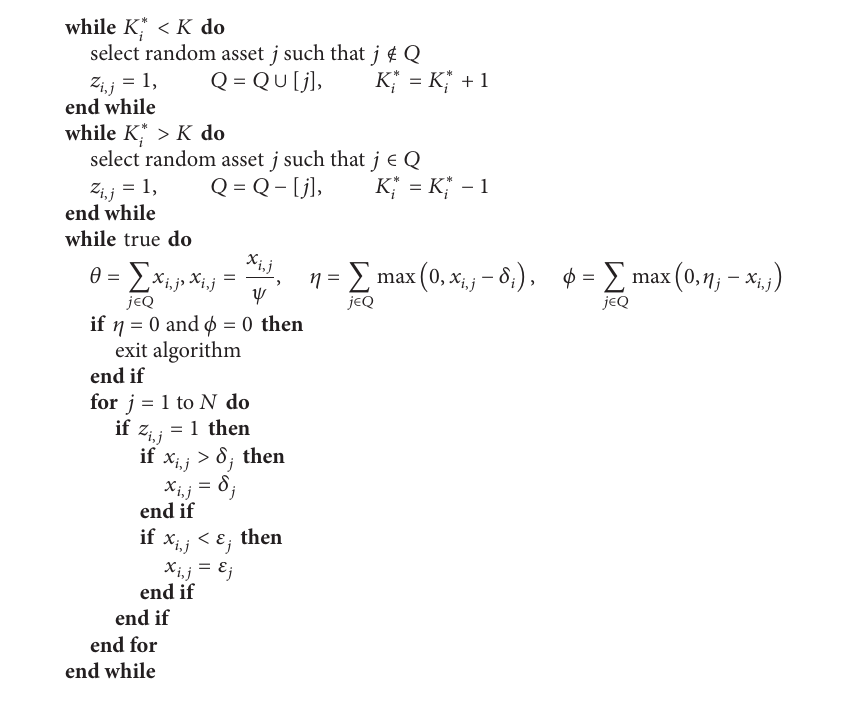
Algorithm 2: Arrangement